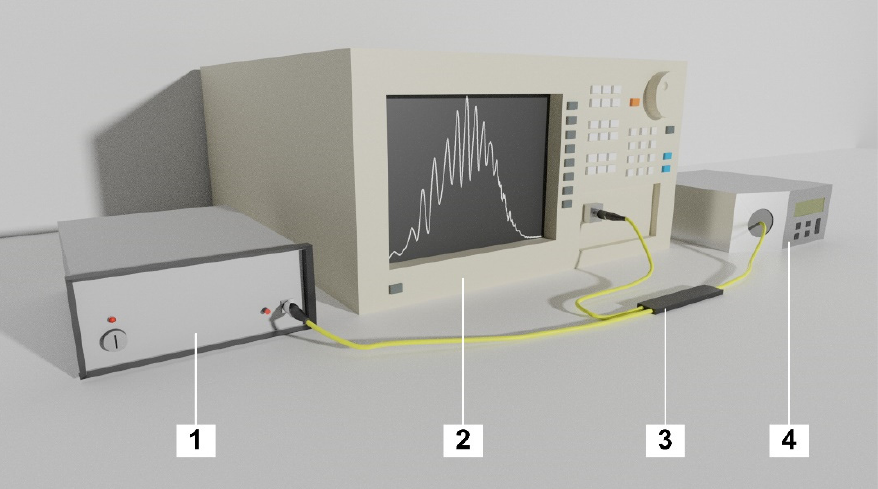
Figure 2. Experimental setup, where: 1—light source, 2—Optical Spectrum Analyzer, 3—Optical fiber coupler, 4—Temperature calibrator.